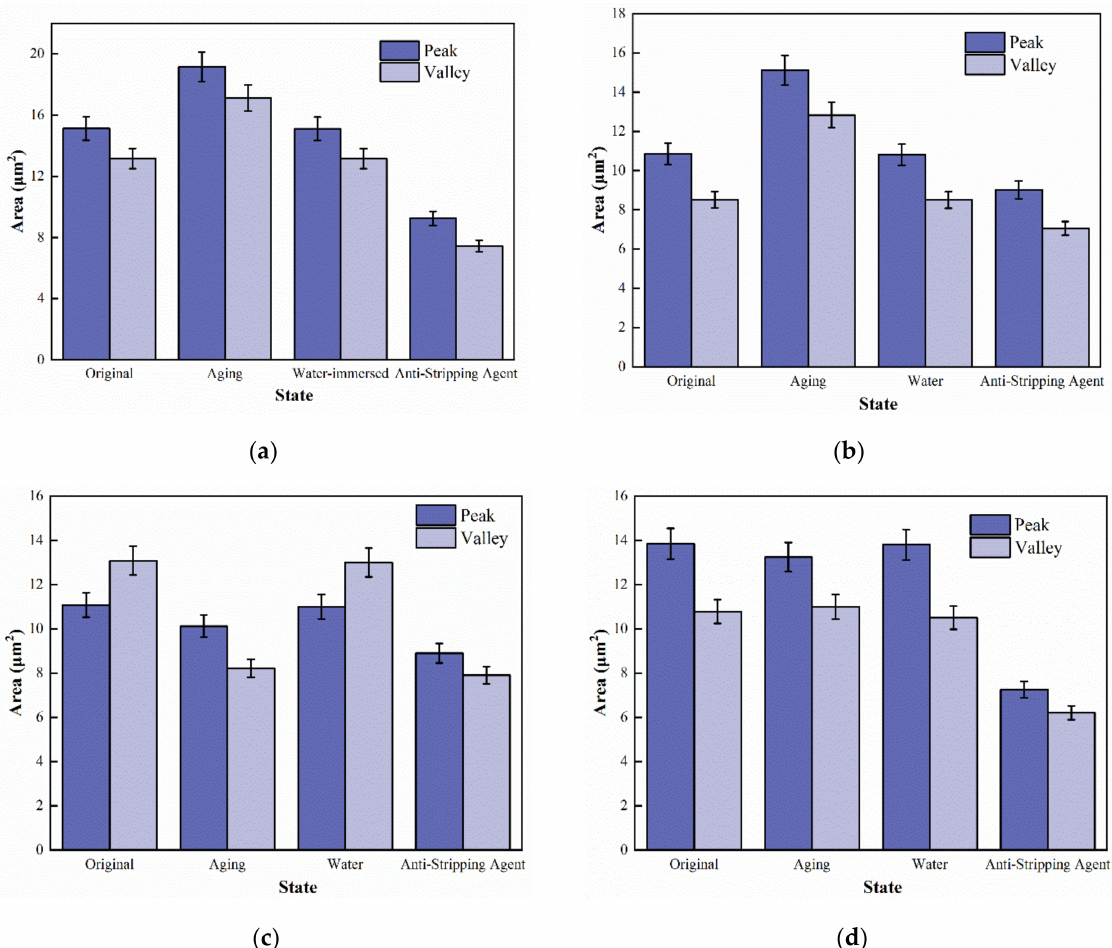
Figure 5. Statistical map of different regions of asphalt binder micro-morphology: ( a ) SK-70, ( b ) Shell-70, ( c ) SK-90, and ( d )